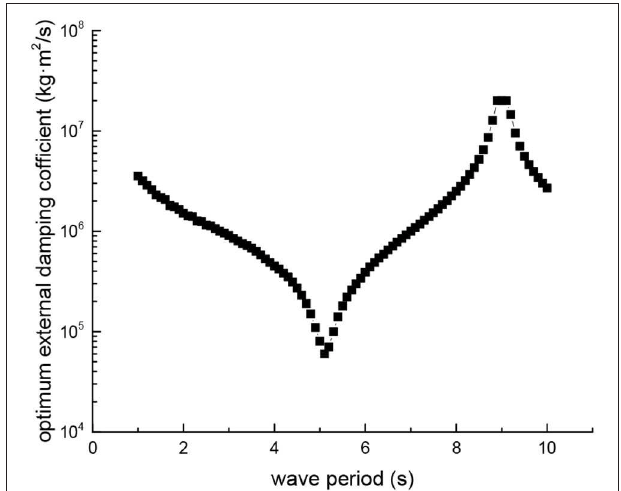
FIGURE 7 | Optimum hydraulic damping